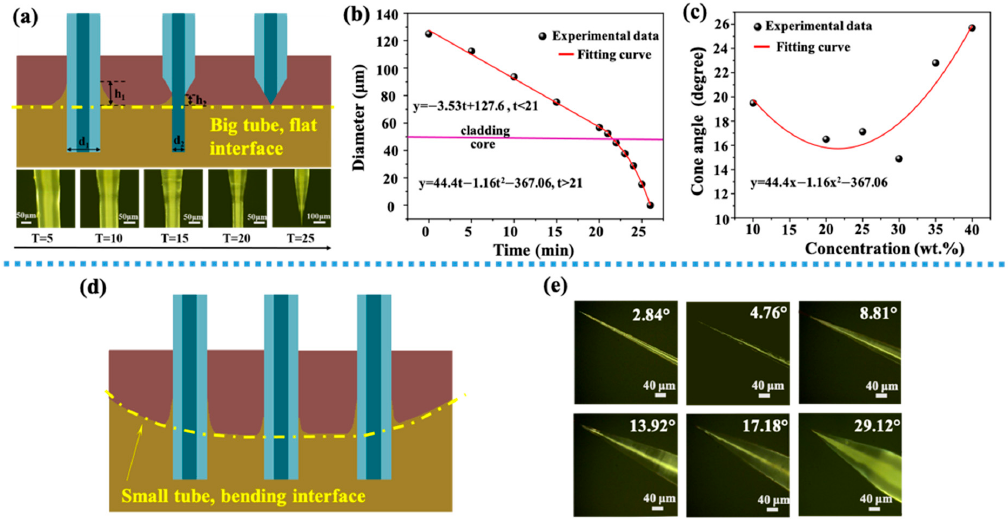
Figure 2. ( a ) Schematic diagram of optical fiber corrosion process (a flat interface), images on the second row show the tip of the fiber at different etching time, with a 5-min interval; ( b ) the relationship between the fiber diameter and the etching time, the red lines are fitting curves for two different stages separated by a horizontal pink line (interface between core and cladding). ( c ) The relationship between HF acid concentration and final cone angle, the red line is a quadratic fitting curve of experimental data. ( d ) Schematic diagram of the meniscus formed by the optical fiber at different positions in a small centrifuge tube (a bending interface). ( e ) Optical images of tapered optical fibers with different angles.